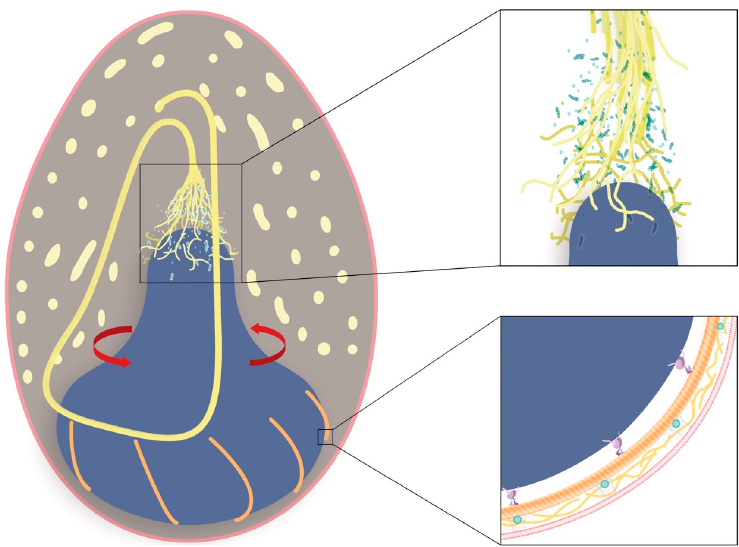
Figure 6. Nuclear rotation hypothesis. The nuclear rotation hypothesis explains how the thread becomes so neatly coiled, with IFs twisted together in to a coherent thread near the apical tip of the nucleus (dark blue), similar to how a spinning wheel twists wool fibers into yarn. The growing thread loops coil within the space defined by the apical surface of the nucleus and the already coiled thread loops (oblique and cross-sections shown in pale yellow). Inset top: IF proteins are synthesized and IFs (yellow) are assembled within the mitochondrial rich zone (MRZ) near the apical tip of the nucleus (green), which is rich in mitochondria and ribosomes (light blue). Inset bottom: Nuclear rotation powered by dynein molecules motors (purple), which process along MTs (orange) that spiral out form a microtubule organizing center at the base of the cell. We speculate that dynein is anchored to the nuclear envelope (green) via KASH protein domains, while the MTs are attached to the plasma membrane (pink) via interactions with formin protein (teal) and actin filaments (gold). Image credit: Jenny Moring and Julia Krolik (Art the Science Inc., Kingston, Canada).